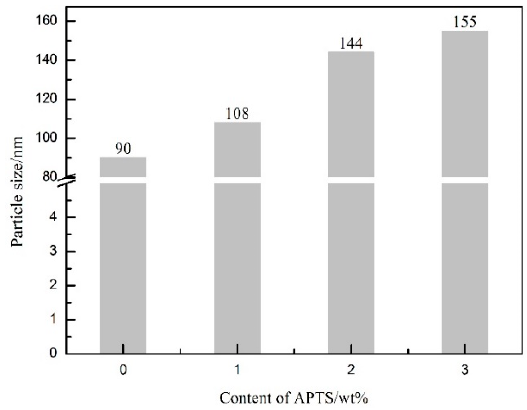
Figure 4. The average particle size of the di ff erent WPU emulsions.